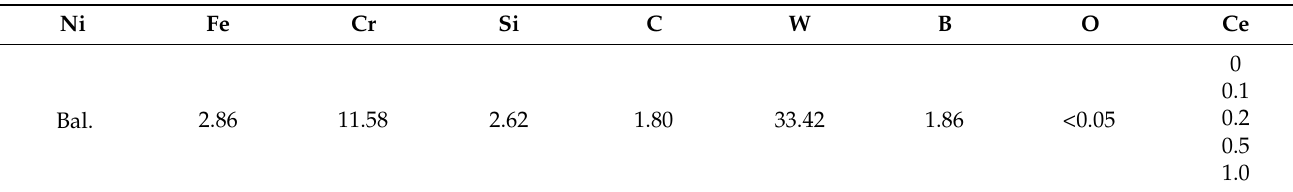
Table 1. Chemical compositions of mixed alloy powder